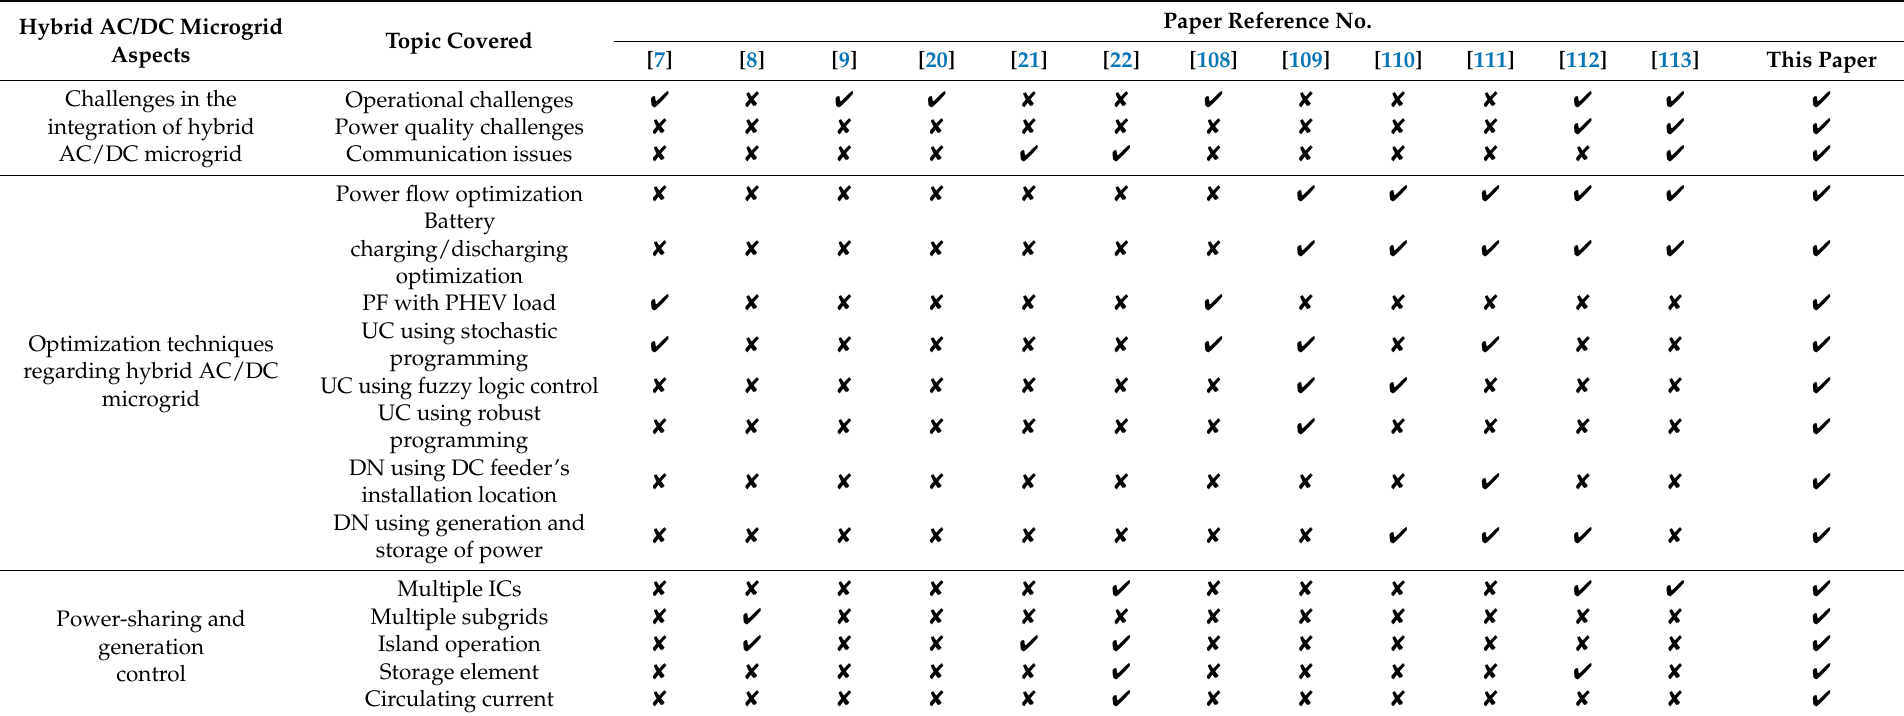
Table 5. Taxonomy of challenges, optimization strategies, and control methodologies of a hybrid